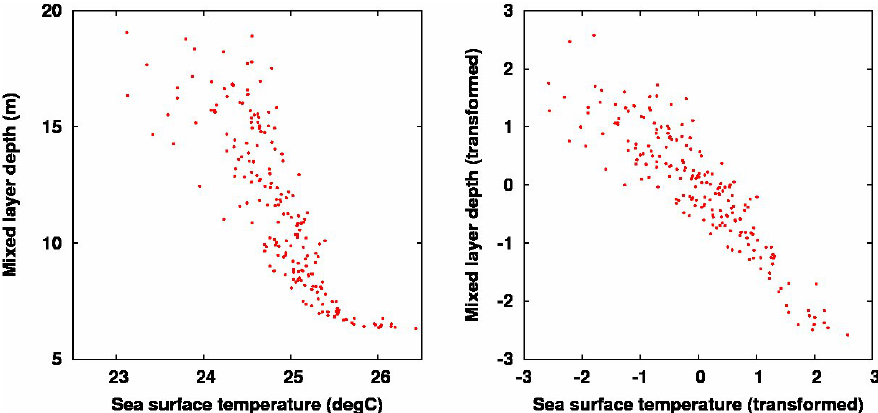
Fig. 5. Scatterplot of MLD vs. SST at 114 ◦ W 0 ◦ N (Eastern Equatorial Pacific), without anamorphosis (left panel), and after local anamor- phosis transformations (right